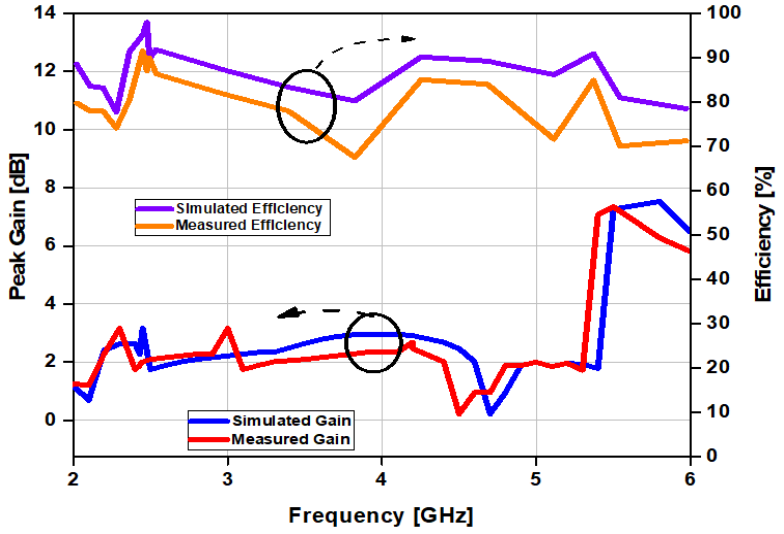
Figure 15. Simulated and measured gain and efficiency of the antenna on human tissues.